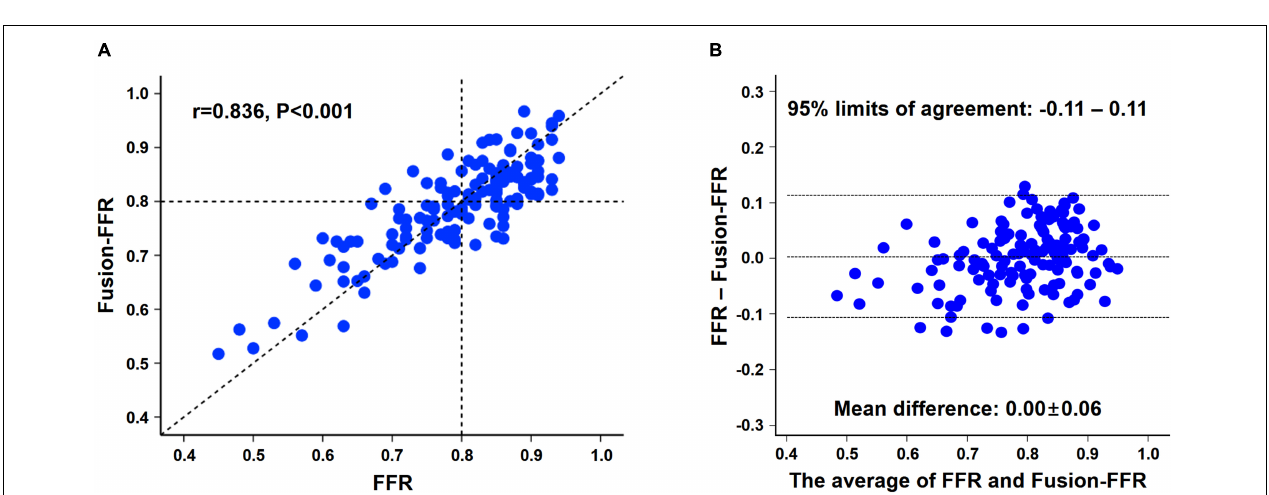
FIGURE 2 | Relationship between pressure wire-based FFR and Fusion-FFR. Correlation (A) and agreement (B) between pressure wire-based FFR and Fusion-FFR. FFR, fractional flow reserve; Fusion-FFR, computational FFR from coronary CTA-OCT fusion images.